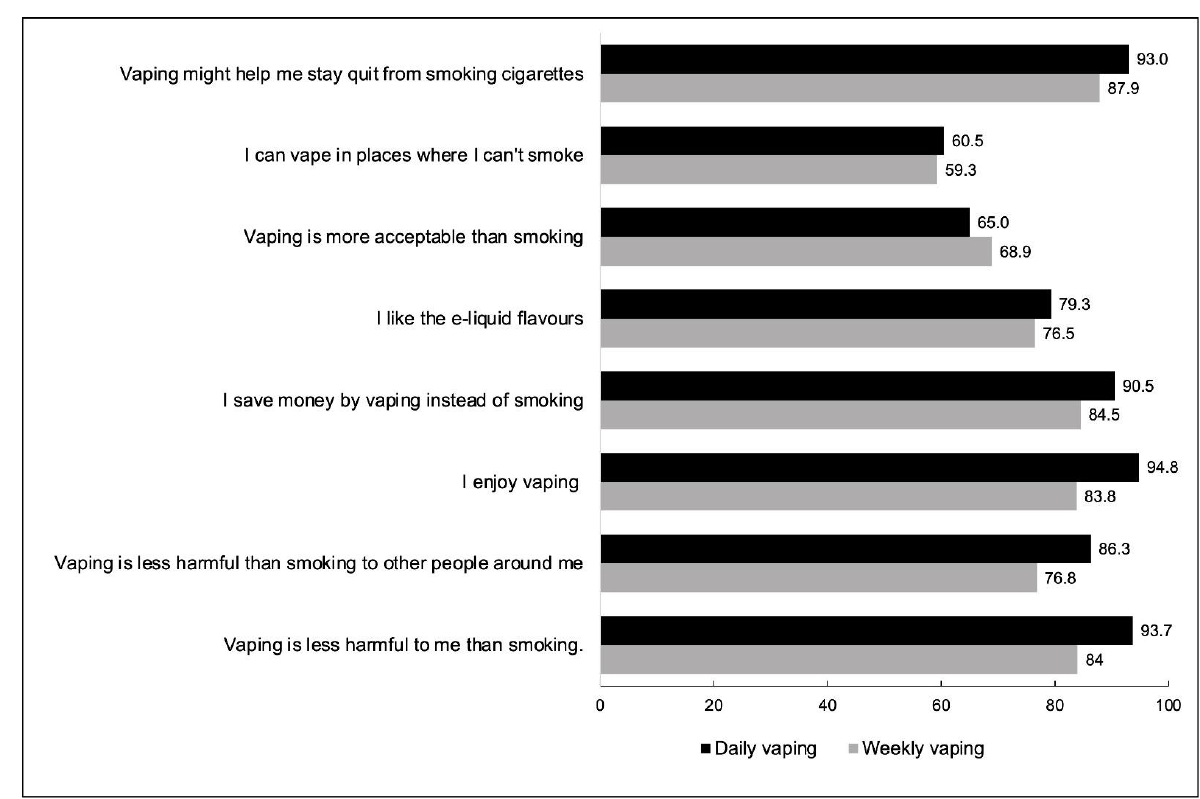
Figure 3. Reasons for vaping among ex-smokers by vaping frequency (% yes, weighted) .